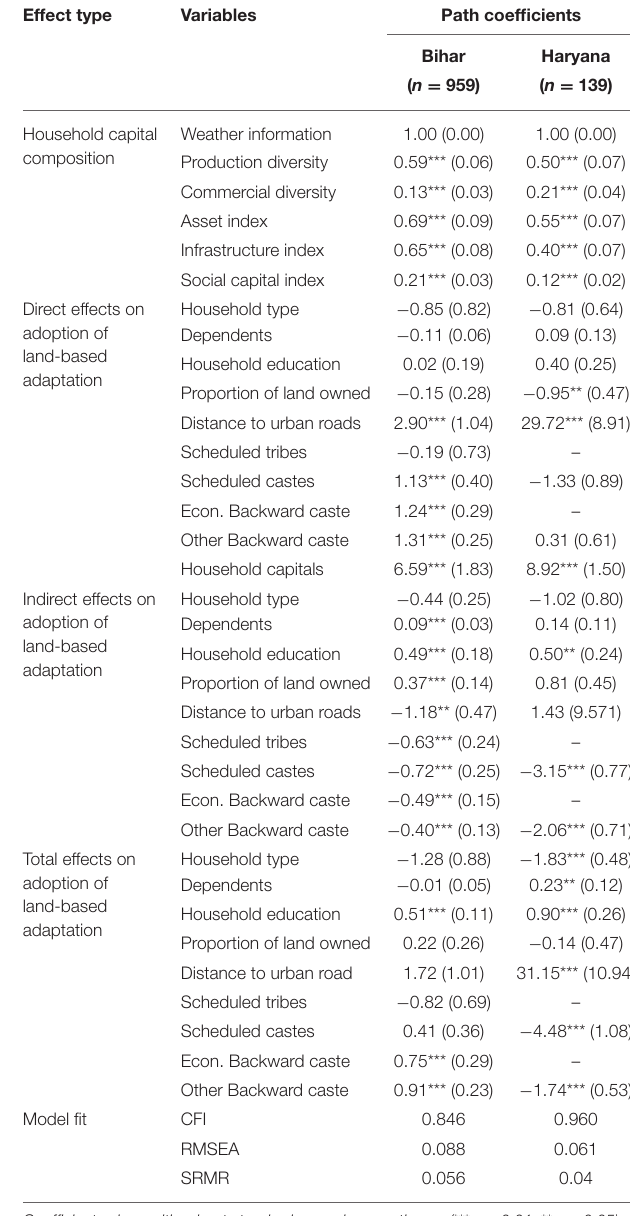
TABLE 5 | SEM results for land-based adaptation strategies in Bihar and